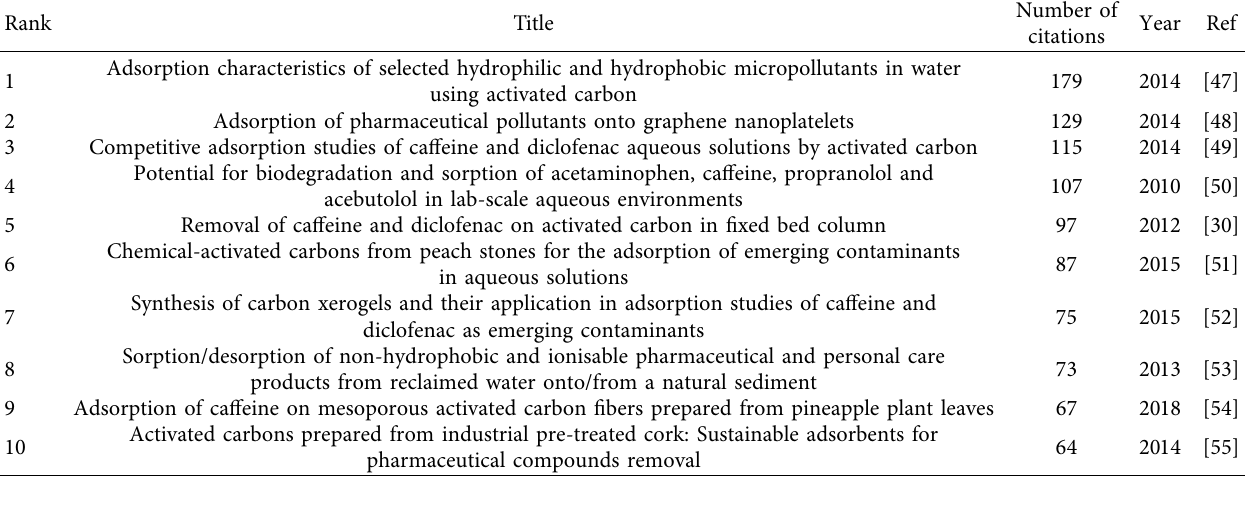
Table 3: Ranking of most cited research articles (excluding reviews).